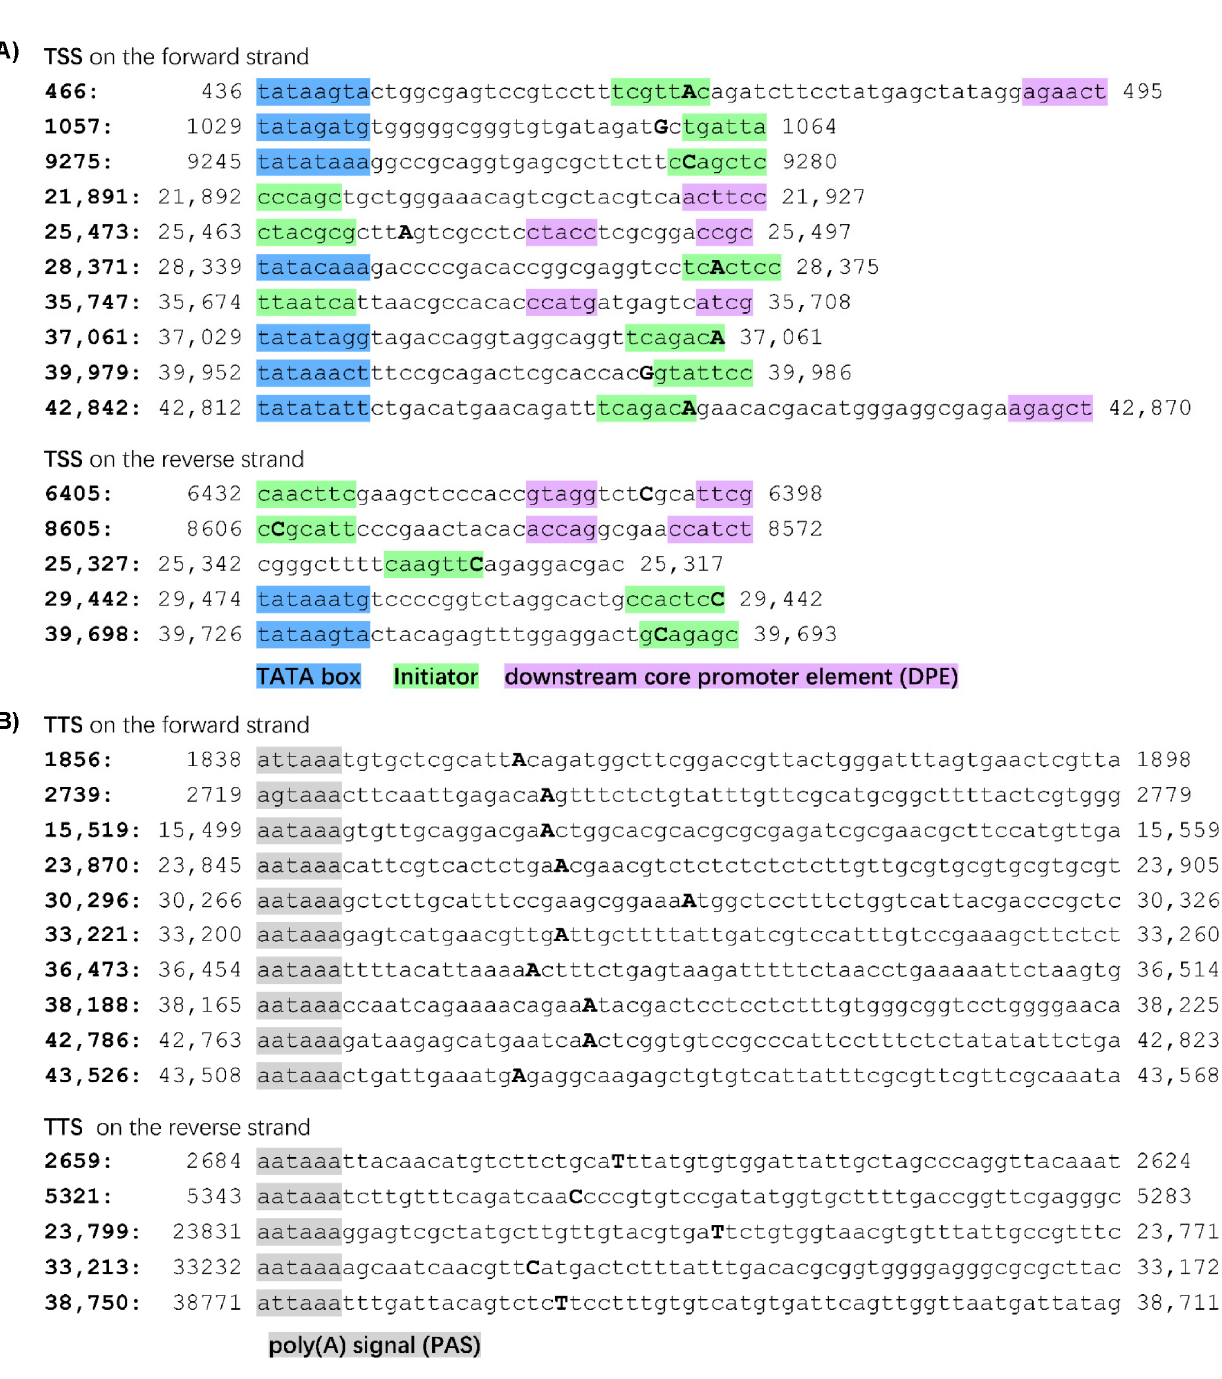
Figure 3. Verification of the found transcription start or termination sites by bioinformatic analysis.